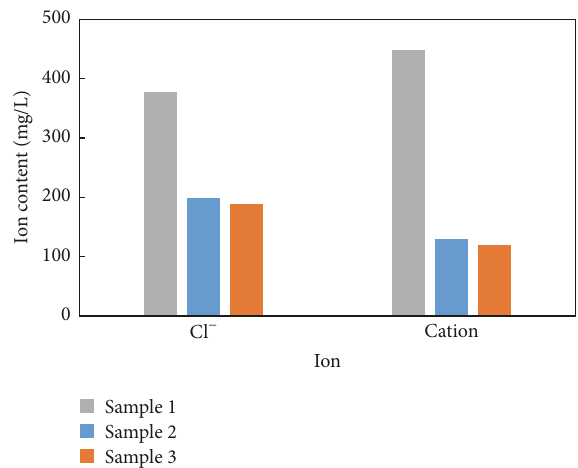
Figure 9: Ion content for the different samples for Case